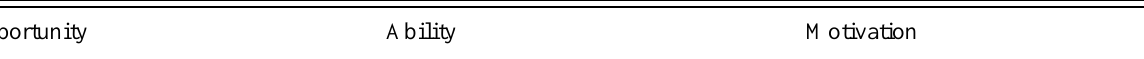
Table 2. Data display of stakeholders' expressed opportunities, abilities and motivations relative to El Niño experiments - additional